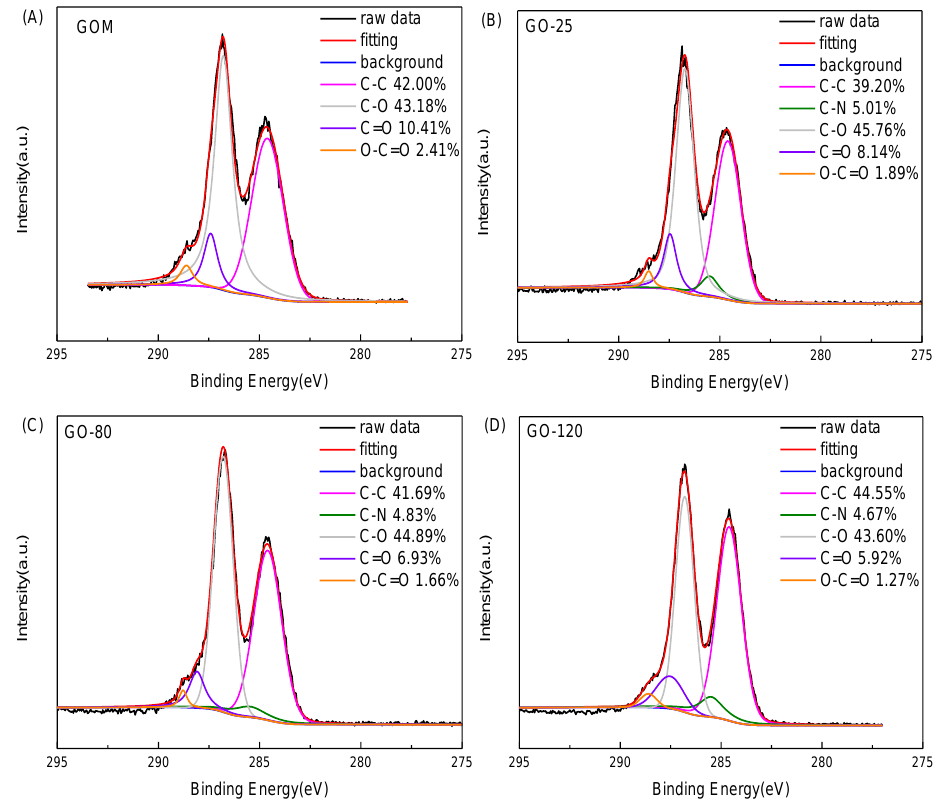
Figure 3. XPS survey spectra of ( A ) GOM, ( B ) GO-25, ( C ) GO-80, ( D ) GO-120.